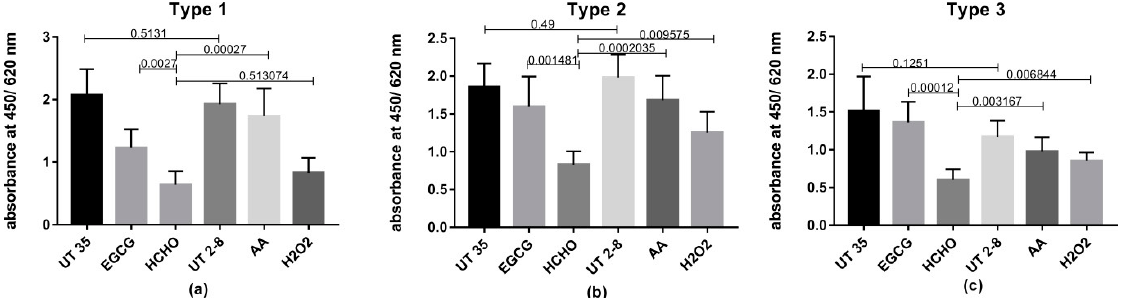
Figure 2. Retention of D-antigens of the three PV serotypes following inactivation by different inactivating agents determined using ELISA. Each column represents the mean absorbance values obtained from the different inactivated vaccine preparations when tested at the end of inactivation period. Two untreated control groups of polioviruses one kept at 35 °C (UT35) and the other at 2–8 °C (UT2-8) were tested as well. The error bars represent the standard deviation (SD). The capped lines represent the compared groups and the numbers written above the capped lines are the p -values. ( a ) PV1 results, ( b ) PV2 results and ( c ) PV3 results.